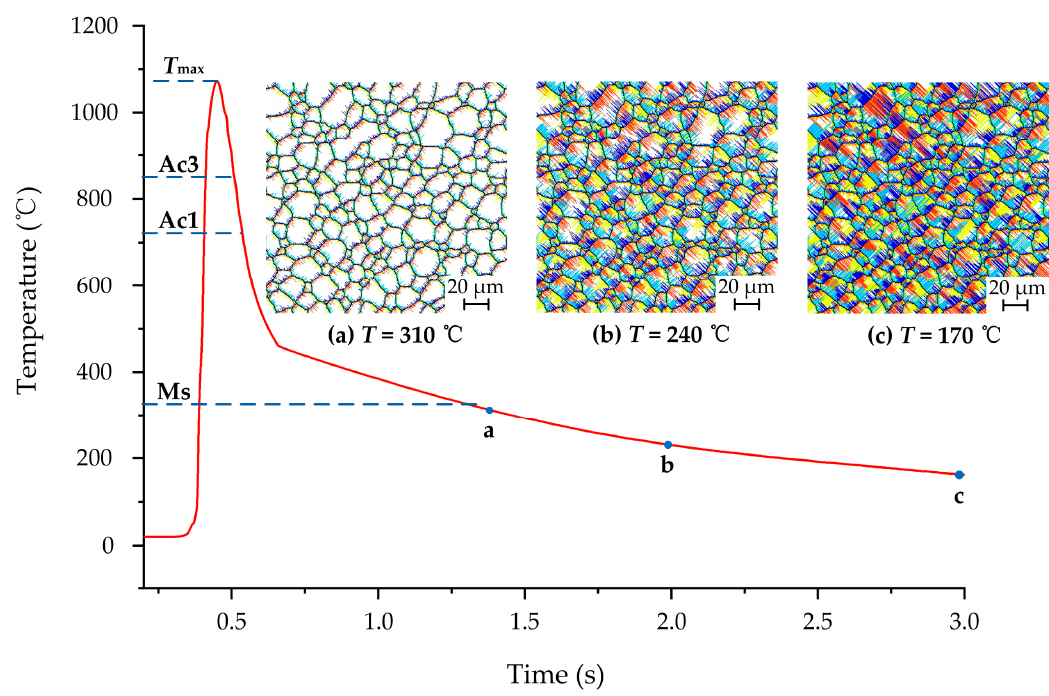
Figure 8. Martensite transformation on workpiece surface at different cooling temperatures: ( a ) T = 310 °C; ( b ) T = 240 °C; ( c ) T = 170 °C.